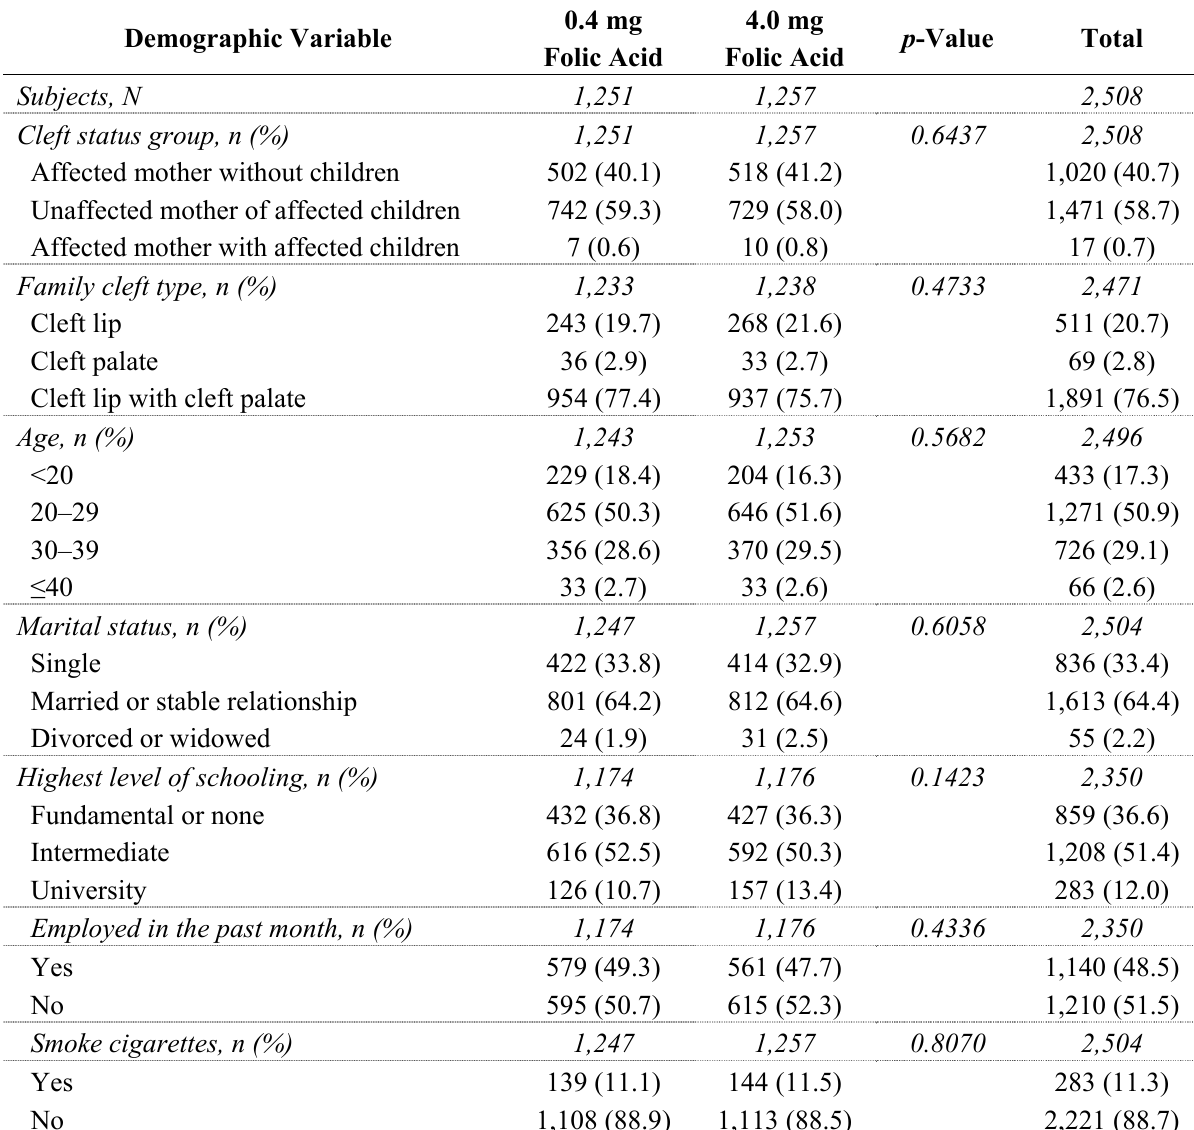
Table 1. Baseline confounders by